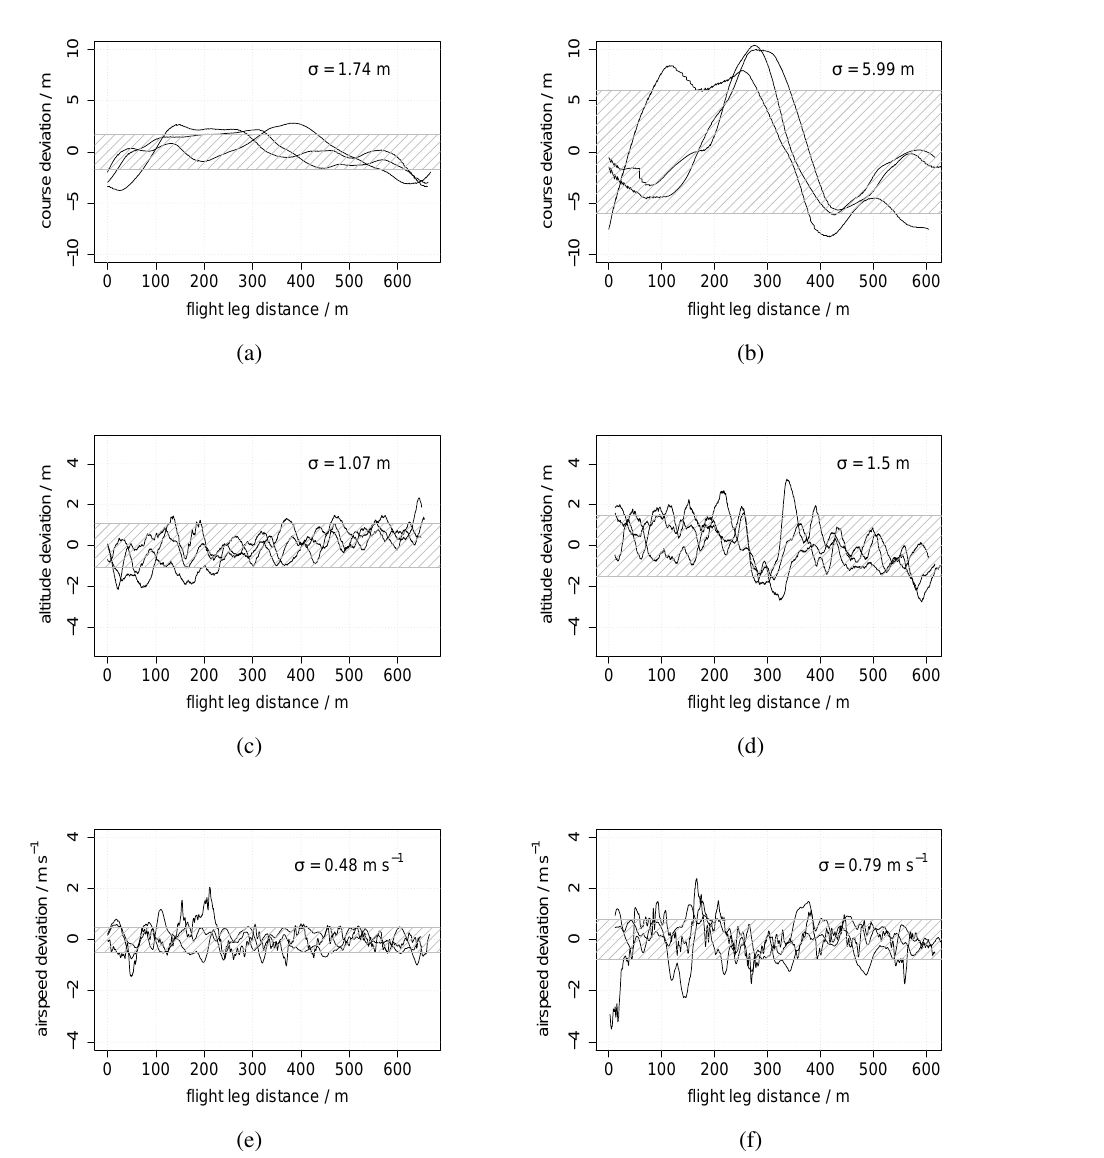
Figure 5. Performance of MASC with ROCS autopilot in undisturbed atmosphere (a),(c),(e) and behind a wind turbine (b),(d),(f). All data were measured during the same flight (see green track in Fig. 3). The figures show three successive, individual flight legs at 100m altitude (=hub height). Offsets between demanded values for course, altitude and airspeed were subtracted and can be higher than the standard deviations σ . An average wind speed of 7ms − 1 perpendicular to the flight path was present throughout the flight.